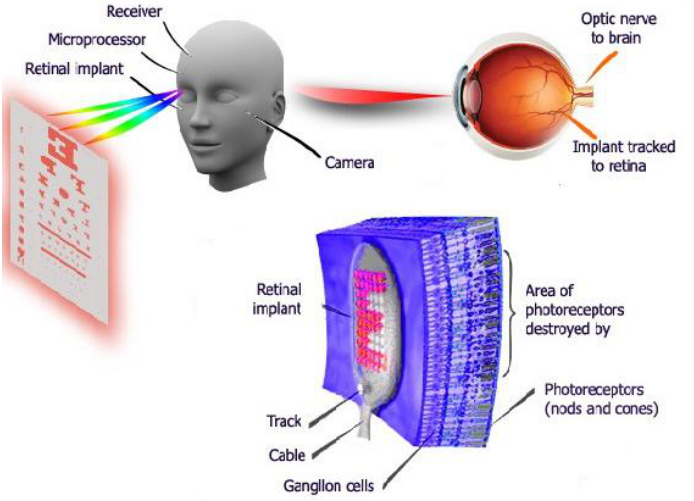
Figure 7. Implantable artificial retina for blind